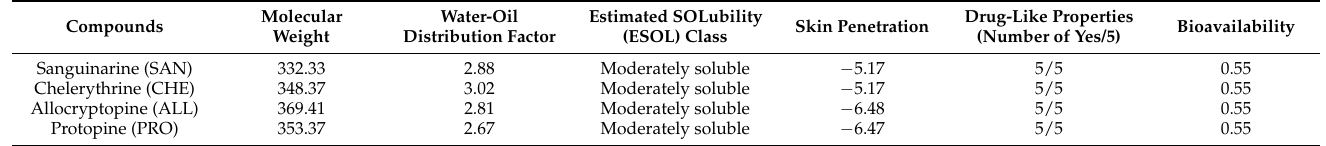
Table 1. The results of the absorption, distribution, metabolism, and excretion (ADME) evaluation of candidate compounds.